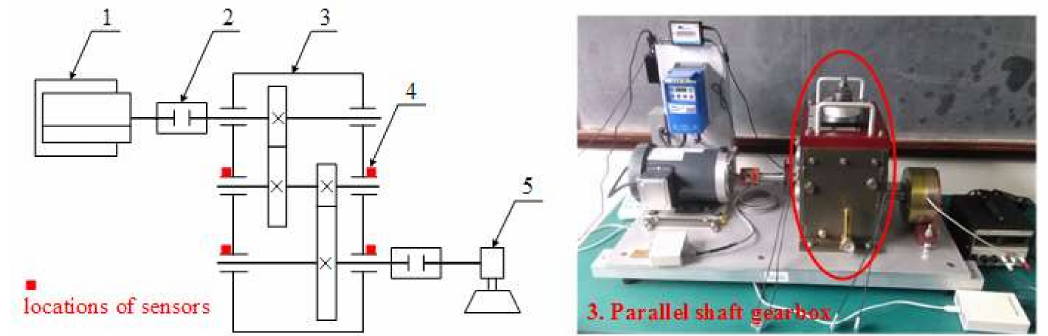
Figure 14. The schematic diagram and the picture of the experimental apparatus. 1-Variable speed drive, 2-Torque transducer and encoder, 3-Parallel shaft gearbox, 4-Test points, 5-Programmable magnetic